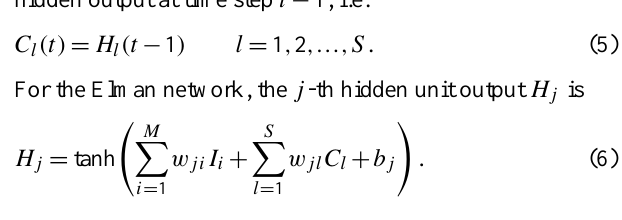
Fig. 4. Architecture of Elman neural network Fig. 3. Architecture of Elman neural Fig. 3. Architecture of Elman neural network